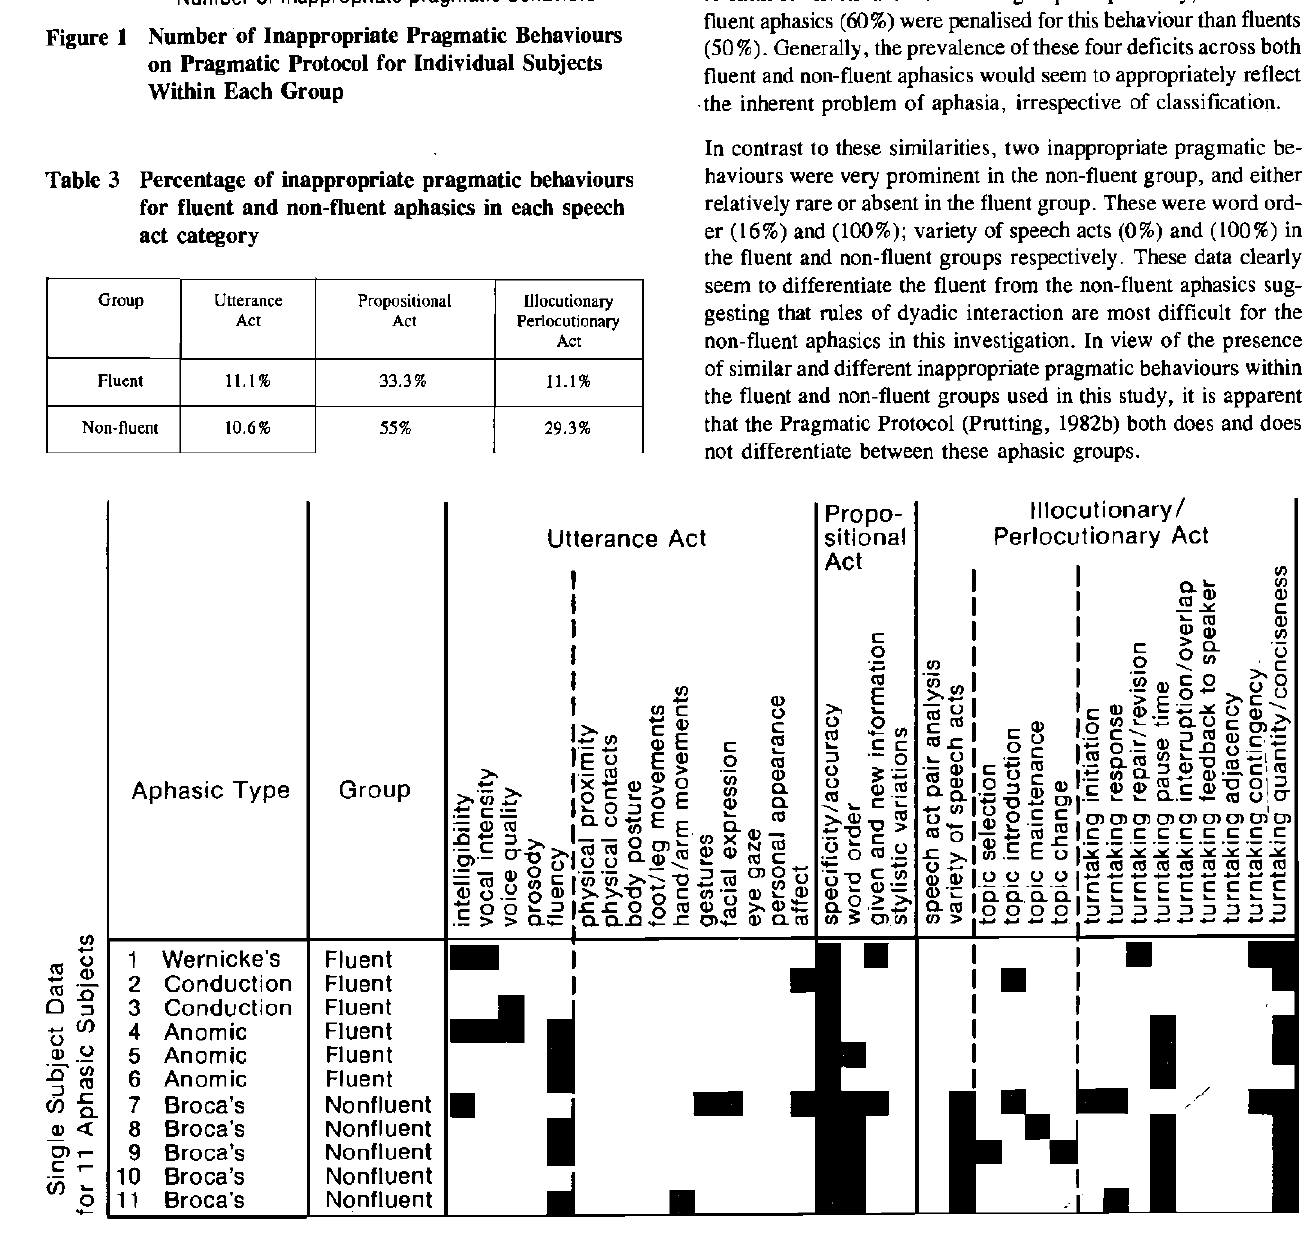
Figure 1 Number of Inappropriate Pragmatic Behaviours on Pragmatic Protocol for Individual Subjects Within Each Group